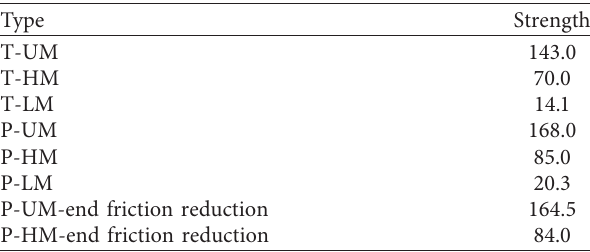
Figure 10: q - ε r and q - ε 1 curves of mortar specimens. (a) T-UM. (b) P-UM. (c) T-HM. (d) Table 3: Uniaxial compressive strengths of mortar specimens with three strengths (MPa).